Question: Name the type of graph shown.
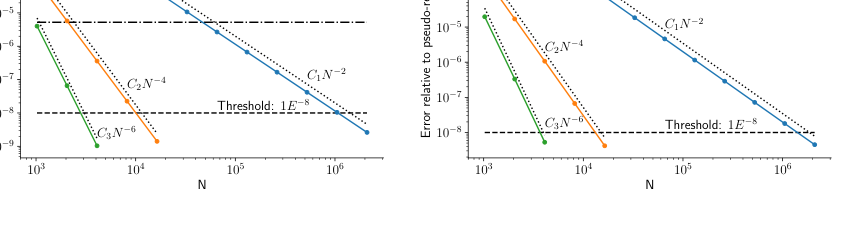
Answer: line